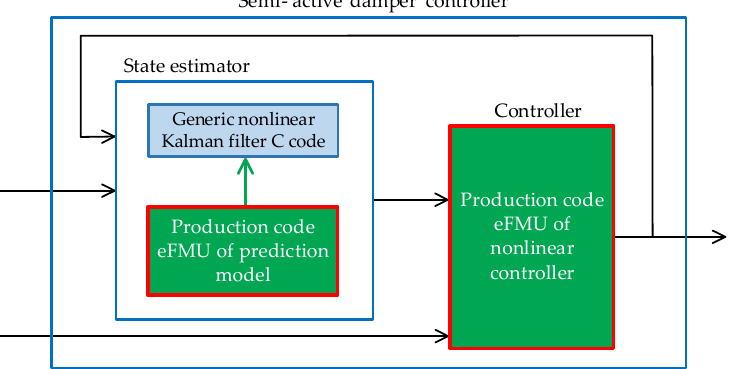
Figure 9. Coupling of the controller eFMU and the state estimator containing an eFMU prediction model.